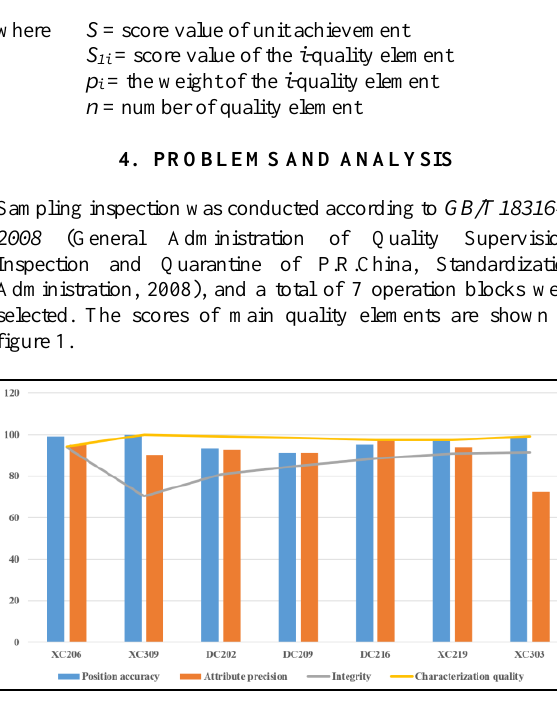
Figure 1 . Scoring statistics of main quality elements.